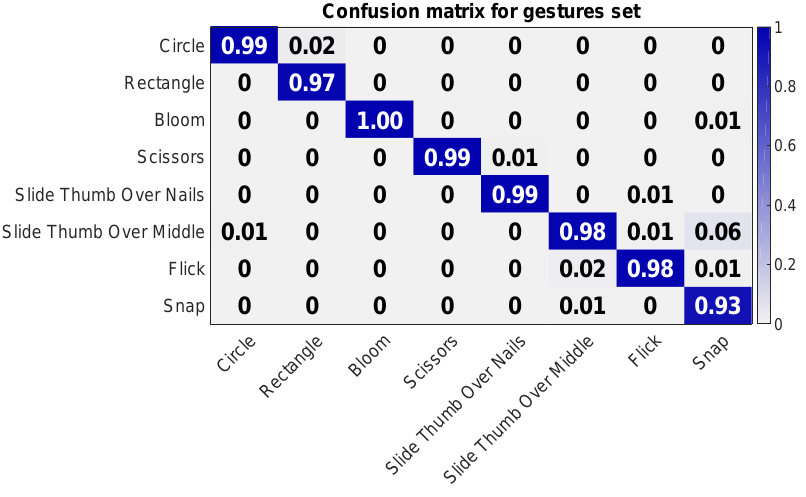
Figure 13. Confusion matrix for the finger gesture set using capacitive measurements, acceleration, and gyroscope data. The columns refer to the actual class, and the rows to the assigned ones during the